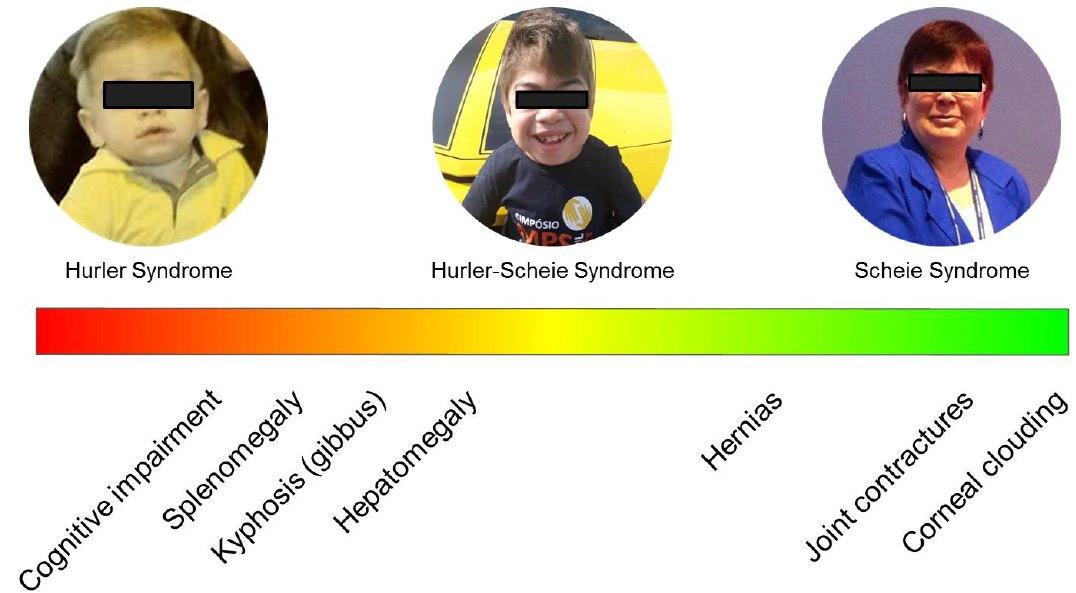
Figure 2. Spectrum of MPS I patients. Manifestations written to the left are more commonly found as presenting signs and symptoms in patients with the severe phenotypes, while those to the right are also frequently seen as presenting signs and symptoms in patients with attenuated phenotypes.